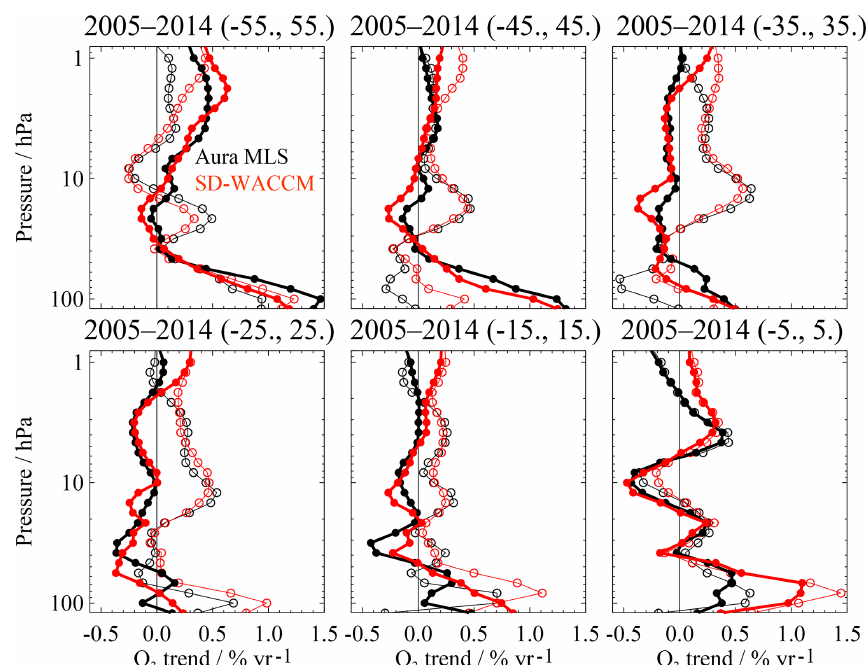
Figure 20. Ozone trends in different latitude bins for SD-WACCM (red) versus Aura MLS data (black) for 2005–2014. Closed and open circles are for northern and southern latitude bins, respectively. For clarity, error bars are omitted here, as these generally show that model– data trend differences are not significant for this time